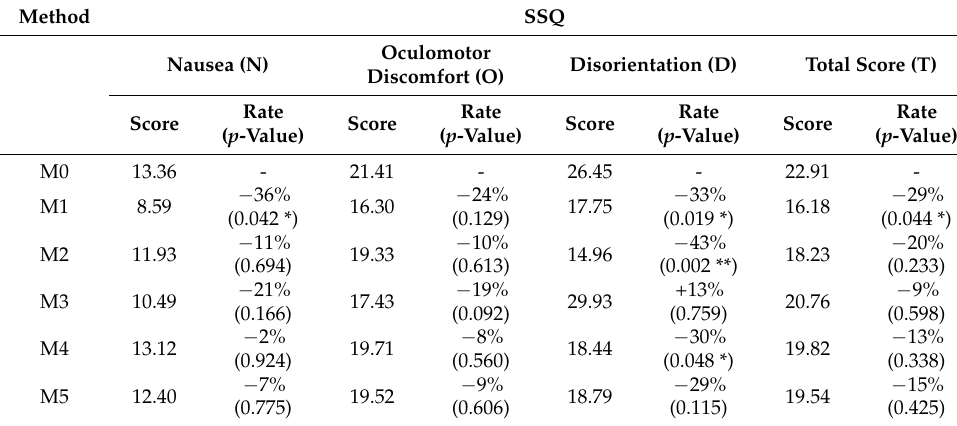
Table 2. VR sickness reduction method used in